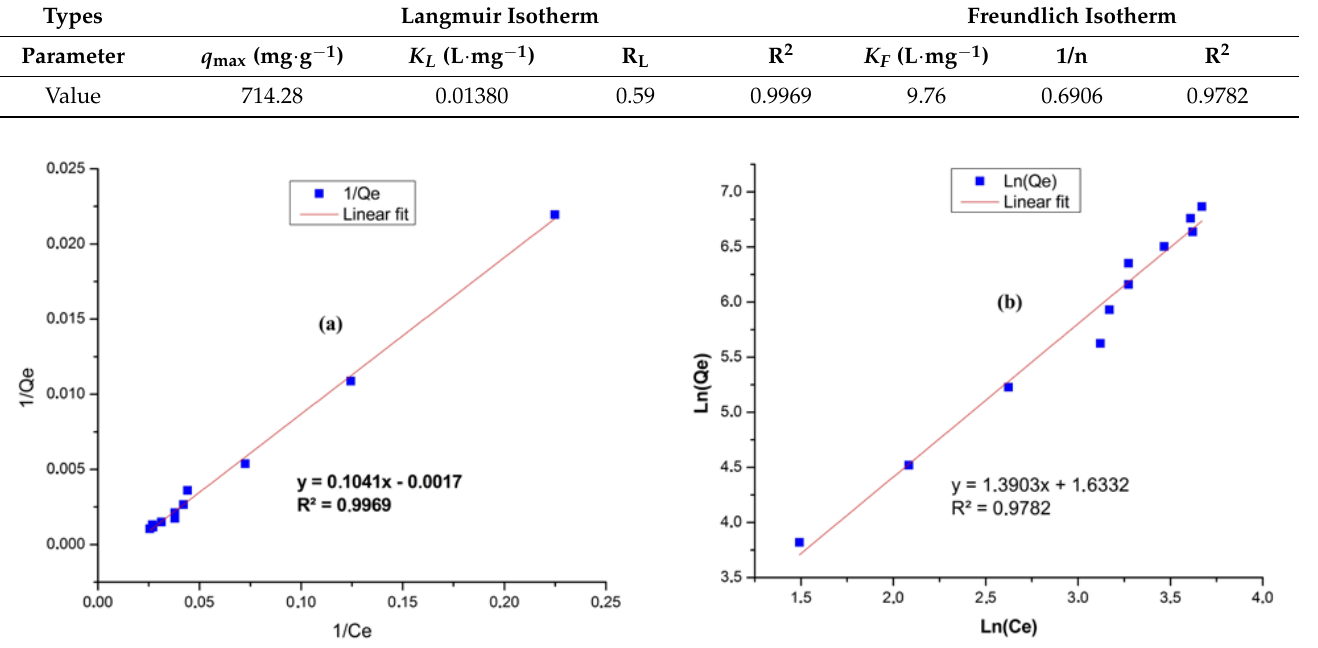
Figure 11. Adsorption isotherm for the TA adsorption by Steel Slag: Langmuir ( a ), Freundlich ( b ). According to the fitting results, the Langmuir isotherm provides higher correlation